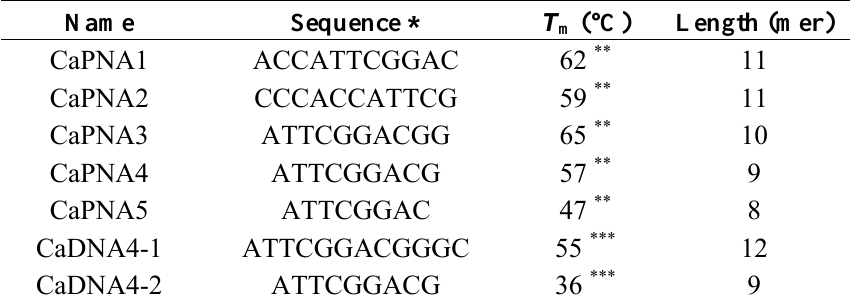
Table 1. Sequences of designed CaDNAs and